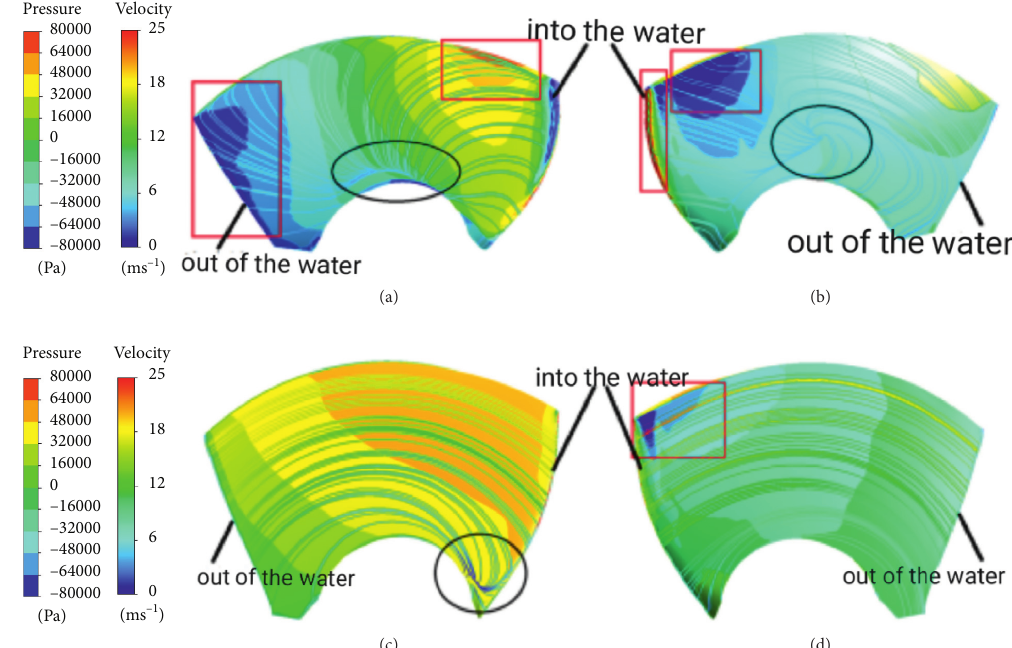
Figure 13: Blade surface pressure and streamline diagram: (a) blade front before optimization; (b) blade back before optimization; (c) optimized blade front; (d) optimized blade